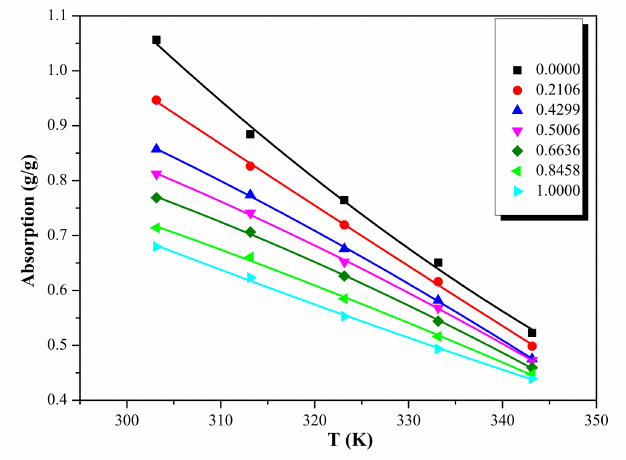
Figure 5. Absorption quantities of NO 2 for the {[EMIM] [TFA] ( χ 1 ) + TEA (1 − χ 1 )} binary systems, as a function of temperatures of binary mixture, at different mole fraction of ILs.